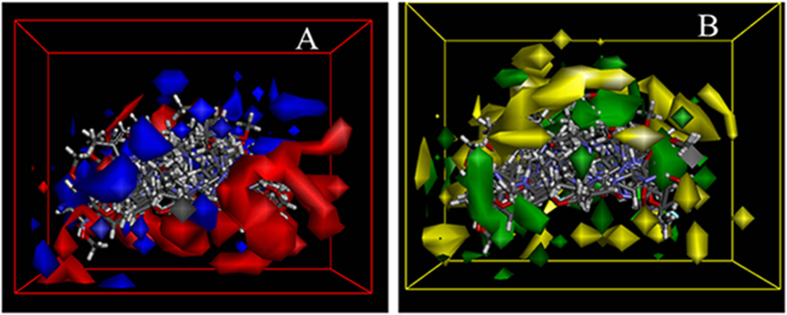
3D-QSAR of designed compounds for EGFR (PDB code: 1M17).(A) Isosurface of the 3D-QSAR model coefficients on electrostatic potential grids. The blue triangle mesh represents positive electrostatic potential and the red area represents negative electrostatic potential. (B) Isosurface of the 3D-QSAR model coefficients on Van der Waals grids. The green triangle mesh representation indicates positive coefficients; the yellow triangle mesh indicates negative coefficients.